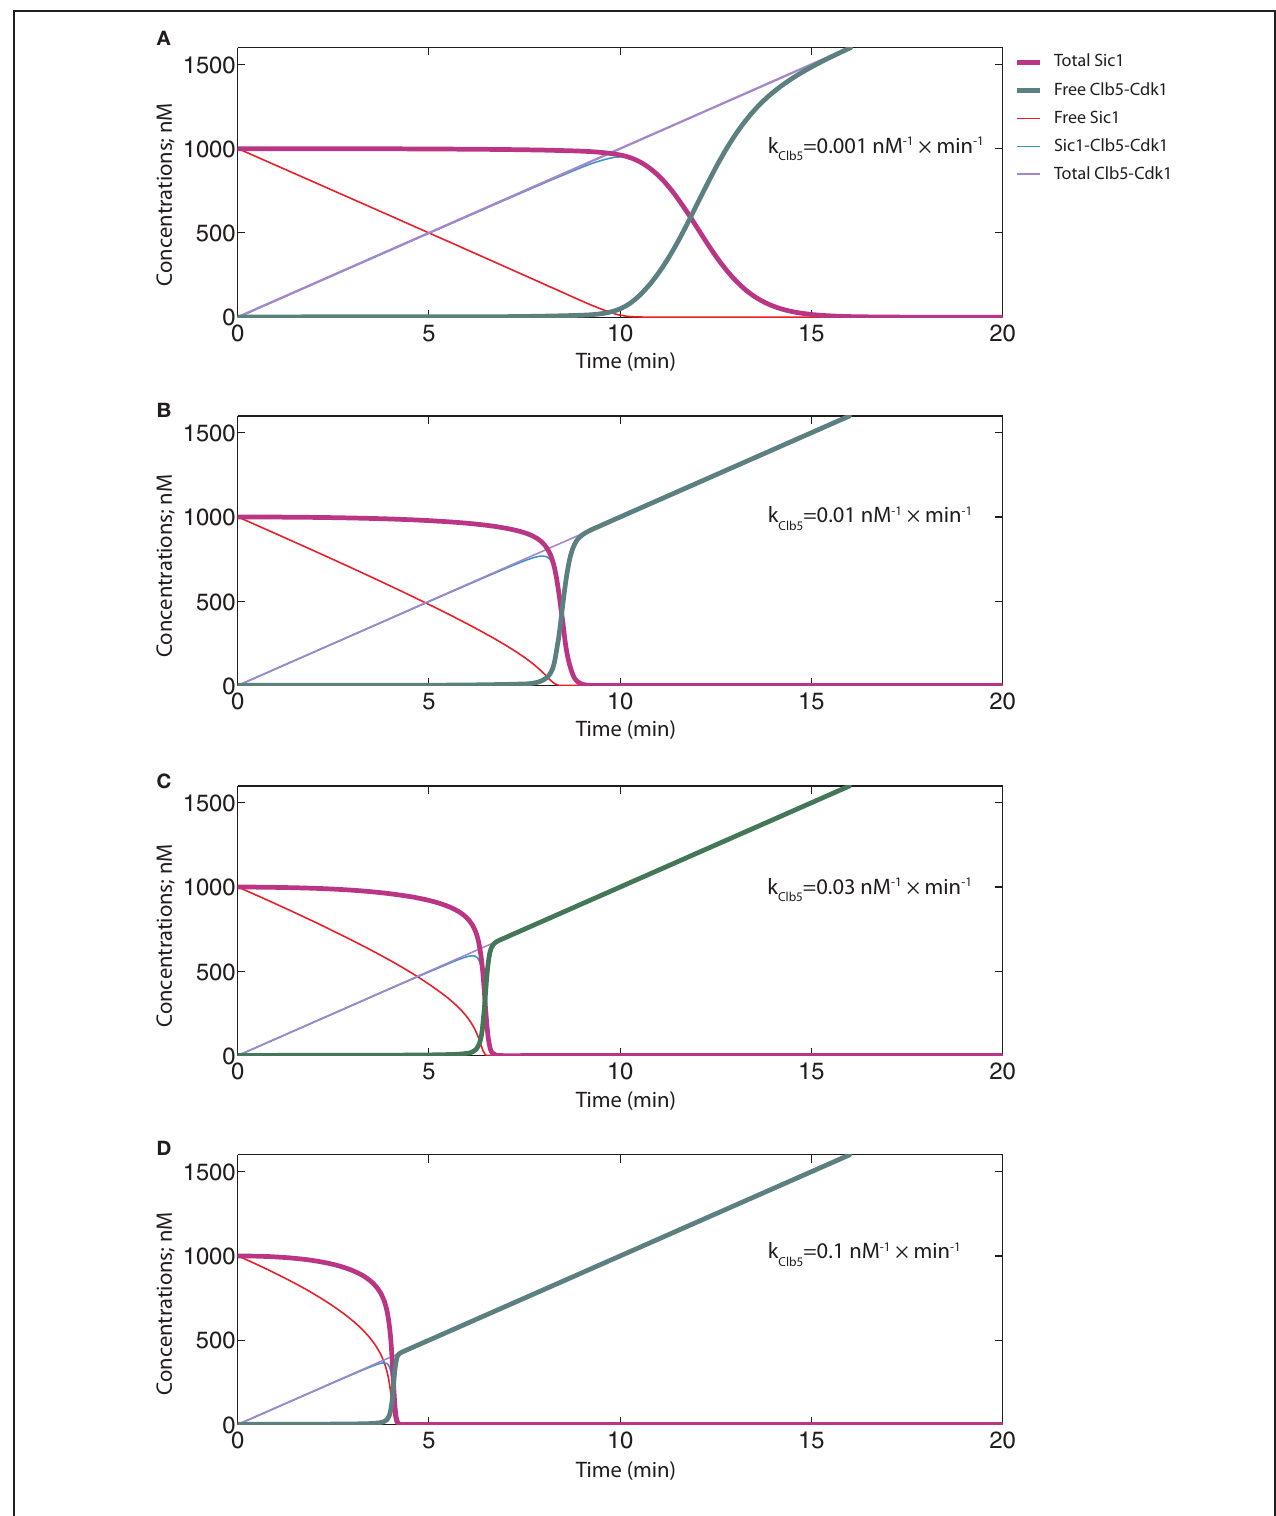
FIGURE 9 | Time course simulations showing the potential effect of Cln2-dependent priming phosphorylation on the abruptness of the switch. The equation system and parameter values are provided in Table 2 . (A) A system with no priming effect in the absence of Cln2. The basal rate